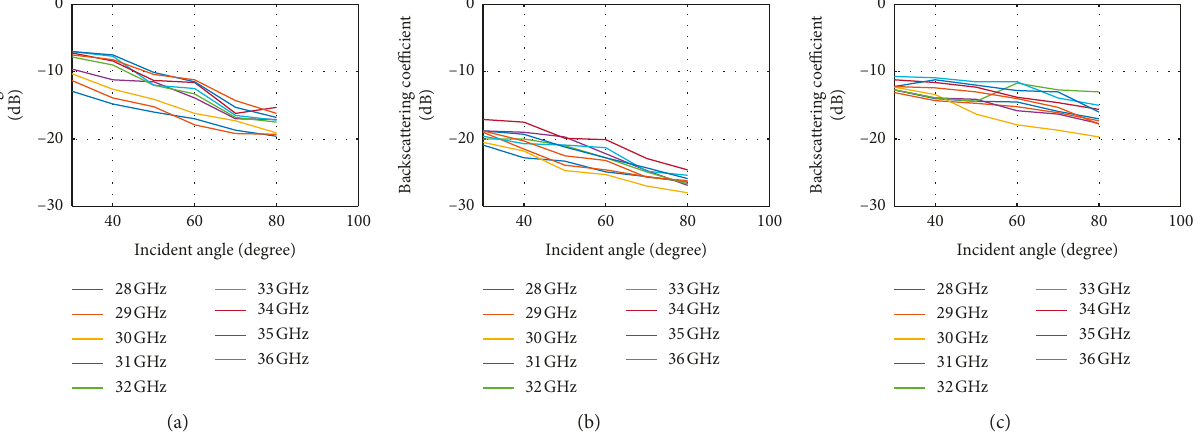
Figure 11: Angular patterns of measured backscattering coefficients of the banyan tree in (a) HH, (b) HV, and (c) VV polarizations from 28GHz to